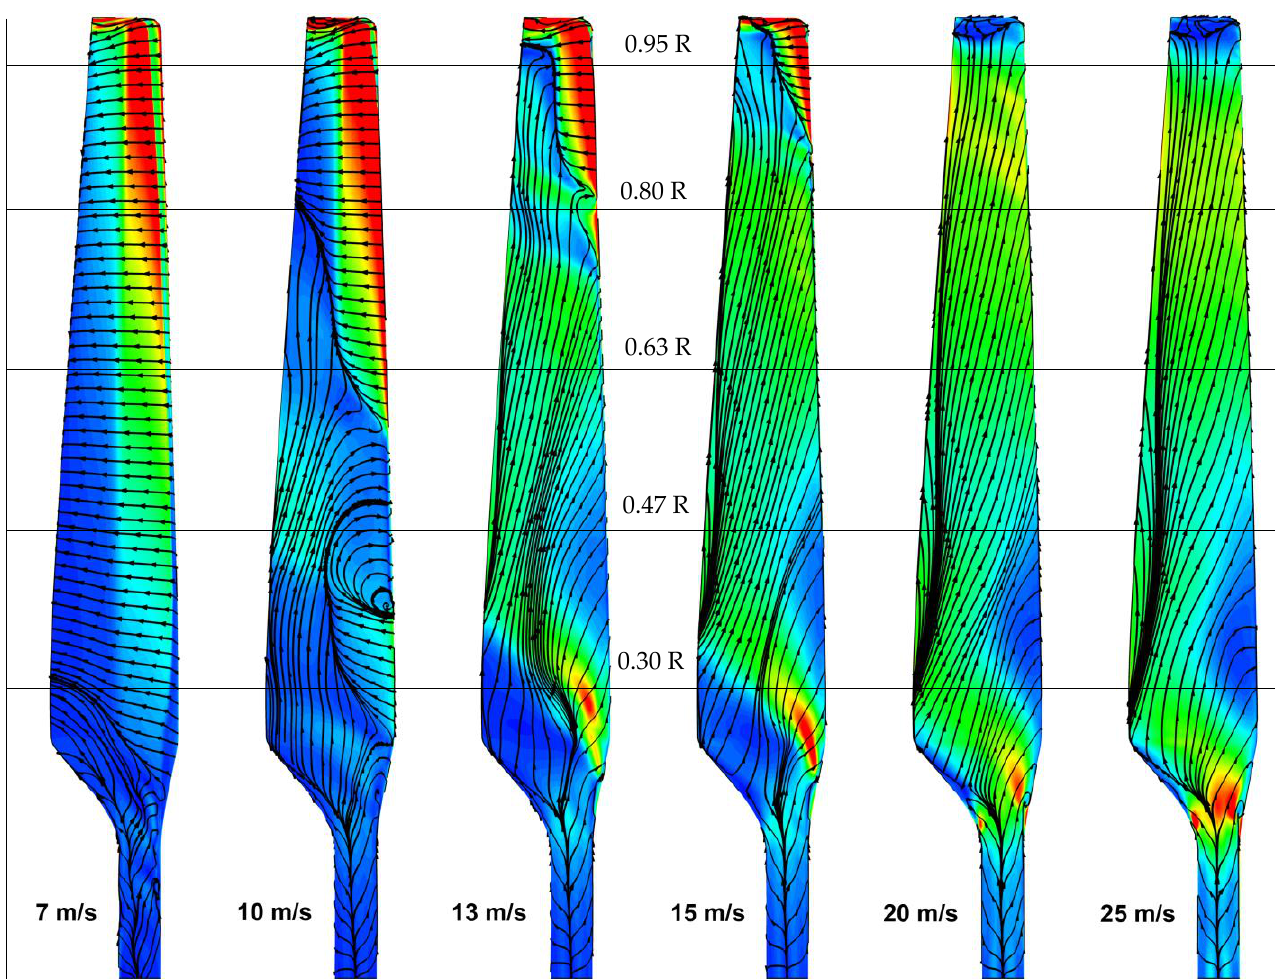
Figure 8. Wall shear stress magnitude contours overlaid with surface streamlines on the blade suction side for the six cases of the initial blind test. The five pressure measurement sections can be located using the horizontal lines. The WSS magnitude range is (0.5) Pa.